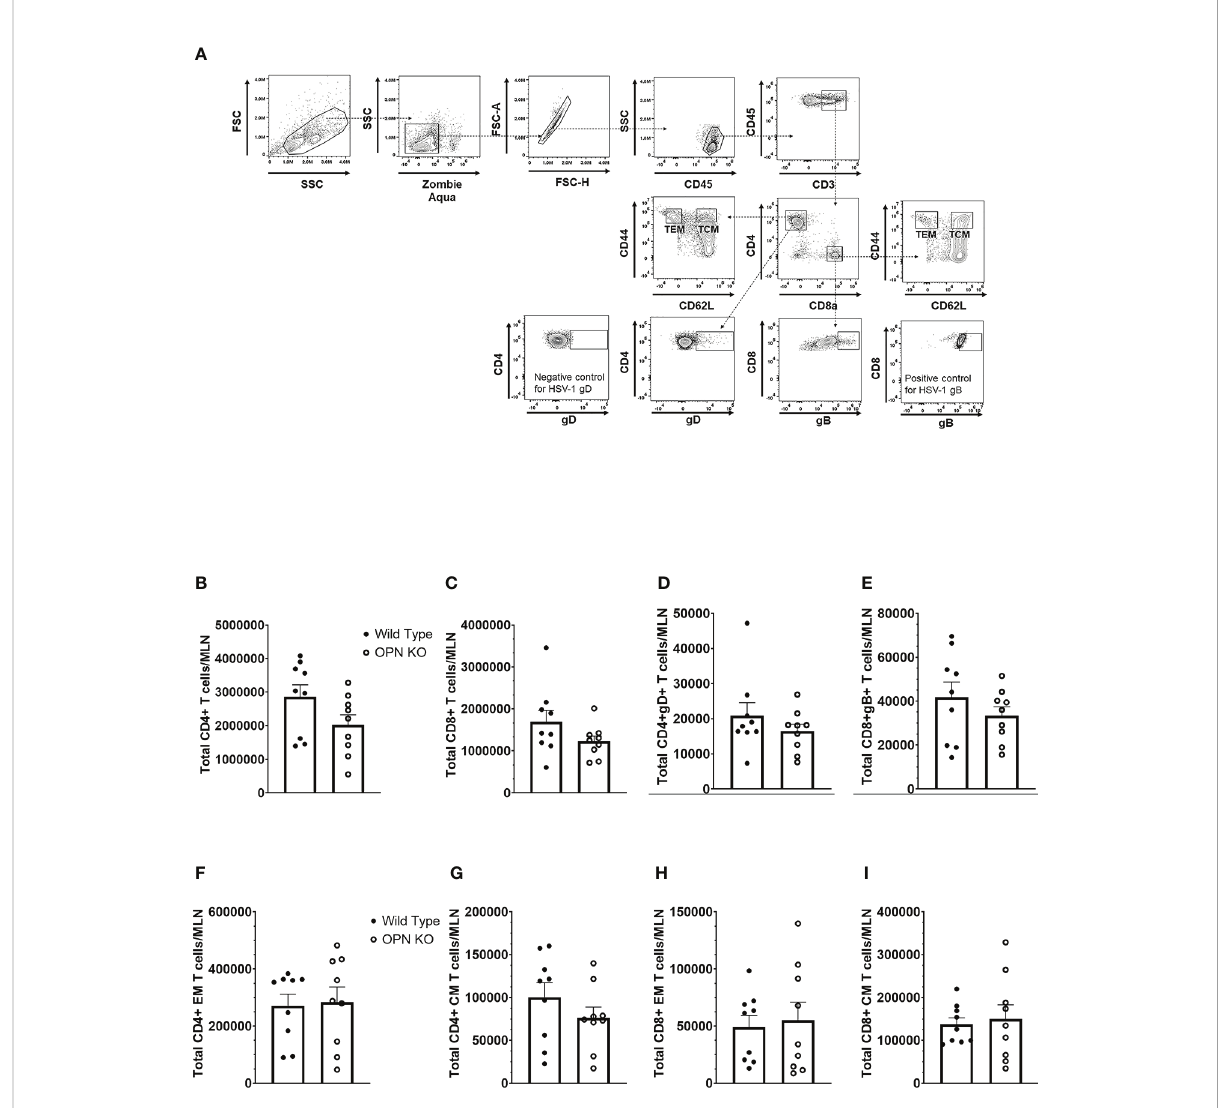
FIGURE 4 Osteopontin does not in fl uence the development of HSV-1-speci fi c T cells in the draining lymph node during acute infection. HSV-1 infected WT and OPN KO male and female mice (n=9/group) were exsanguinated at day 7 PI, and the draining mandibular lymph nodes (MLN) were removed and processed into single cell suspensions. One million cells were stained with an antibody cocktail including Zombie Aqua to discern viable from dead cells. The gating strategy is shown in panel (A) The gD tetramer negative staining control shown in the lower left plot of panel A is: PVSKMRMATPLLMQA conjugated to BV421. The positive control for the gB tetramer staining employed CD8 + T cells from gBT-I.1 transgenic mice in which > 95% of the CD8 + T cells are speci fi c for gB (74). The total number of CD4 + T cells (B) , CD8 + T cells (C) , HSV-1